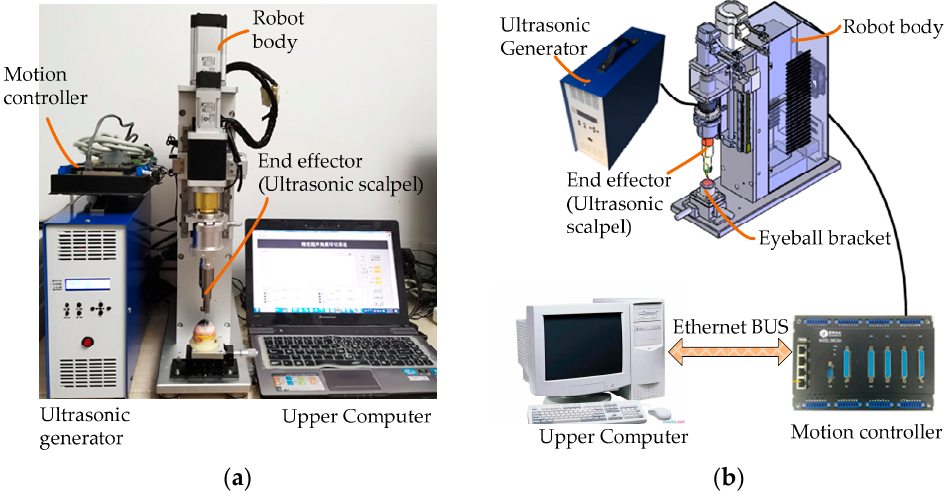
Figure 8. Physical map and component connection schematic diagram of an ultrasound-assisted corneal trephination system. ( a ) Physical map of the system. ( b ) System components’ connection schematic diagram.